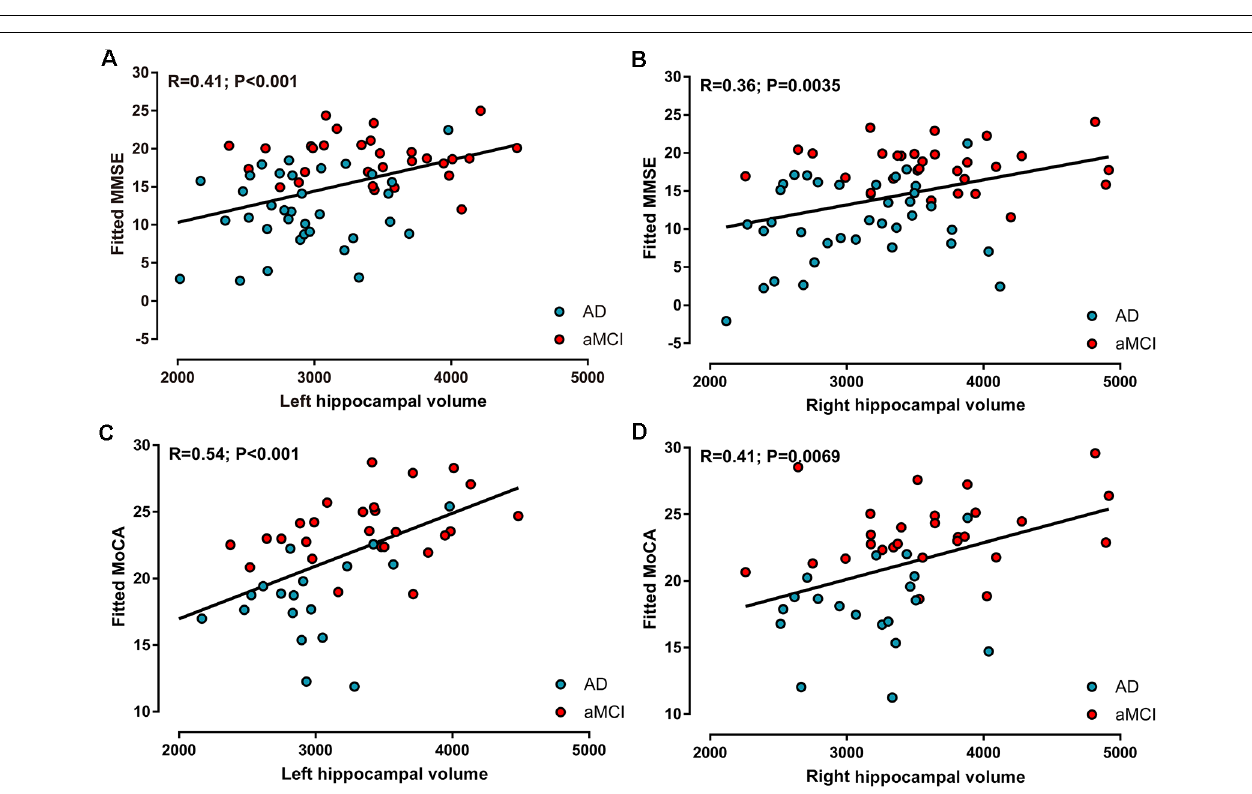
FIGURE 3 | Correlations between neuropsychological tests and hippocampal volume in AD and aMCI patients. (A) Left hippocampal volume was positively correlated with MMSE scores. (B) Right hippocampal volume was positively correlated with MMSE scores. (C) Left hippocampal volume was positively correlated with MoCA scores. (D) Right hippocampal volume was positively correlated with MoCA scores.